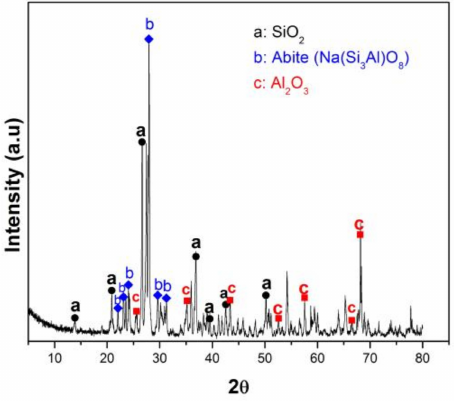
Figure 4. XRD patterns of the composite coating after thermal treatment at 800 ◦